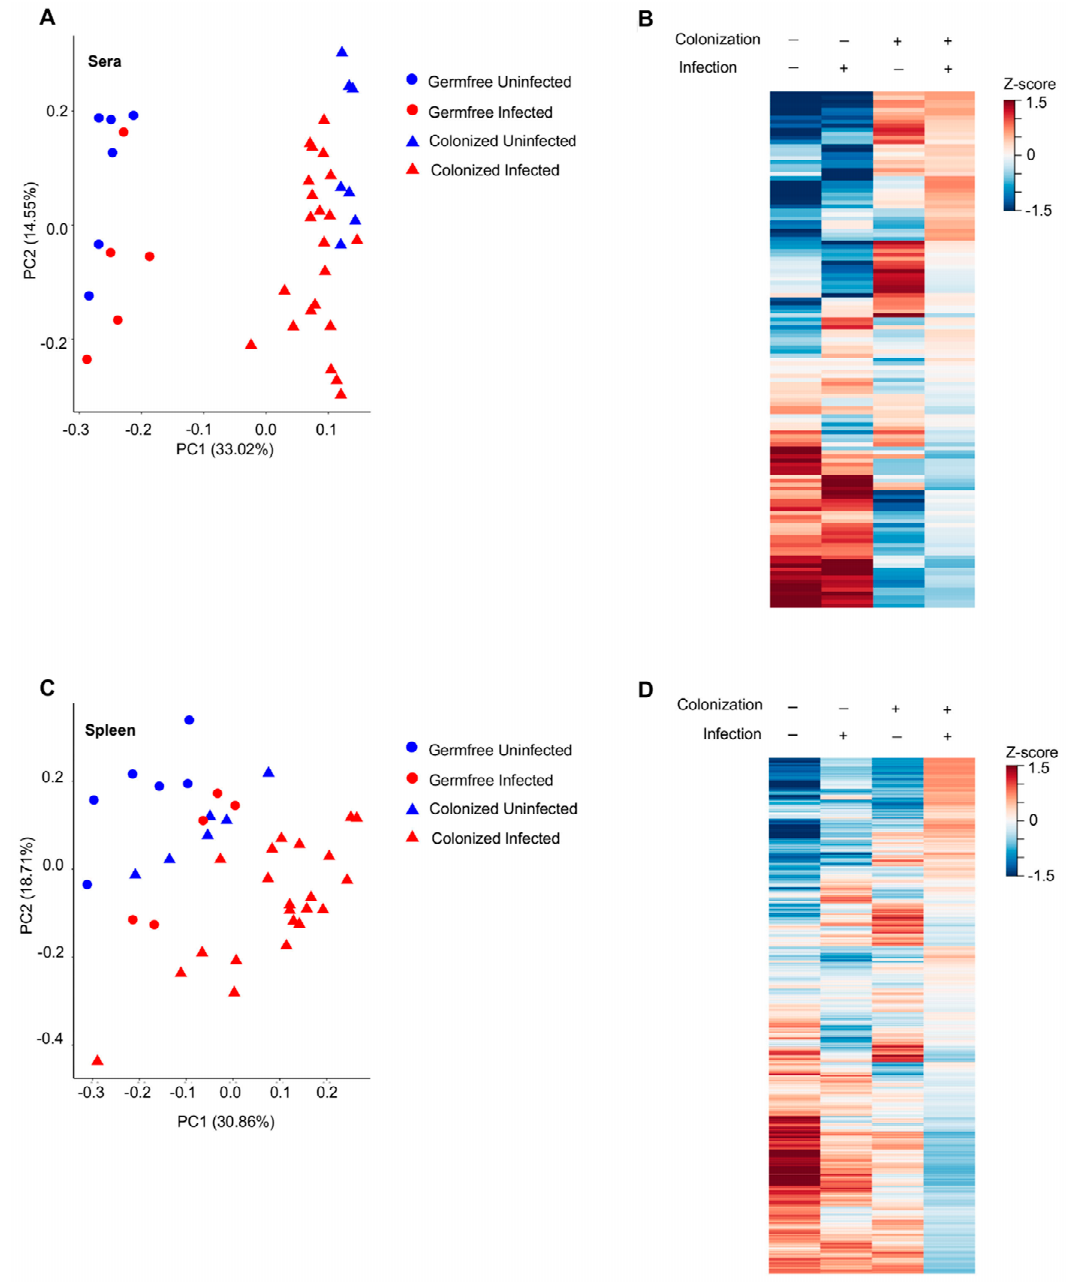
Figure 2. MuLV infection and bacteria colonization alter the metabolomic profile in the sera and spleen. ( A , C ) PCoA plot of all metabolites within the sera ( A ) or spleen ( C ) of the indicated mice. Each point is an individual mouse. ( B , D ) Heatmaps of metabolite abundances in the sera ( B ) or spleen ( D ) of the four groups of mice. Each row is a metabolite.